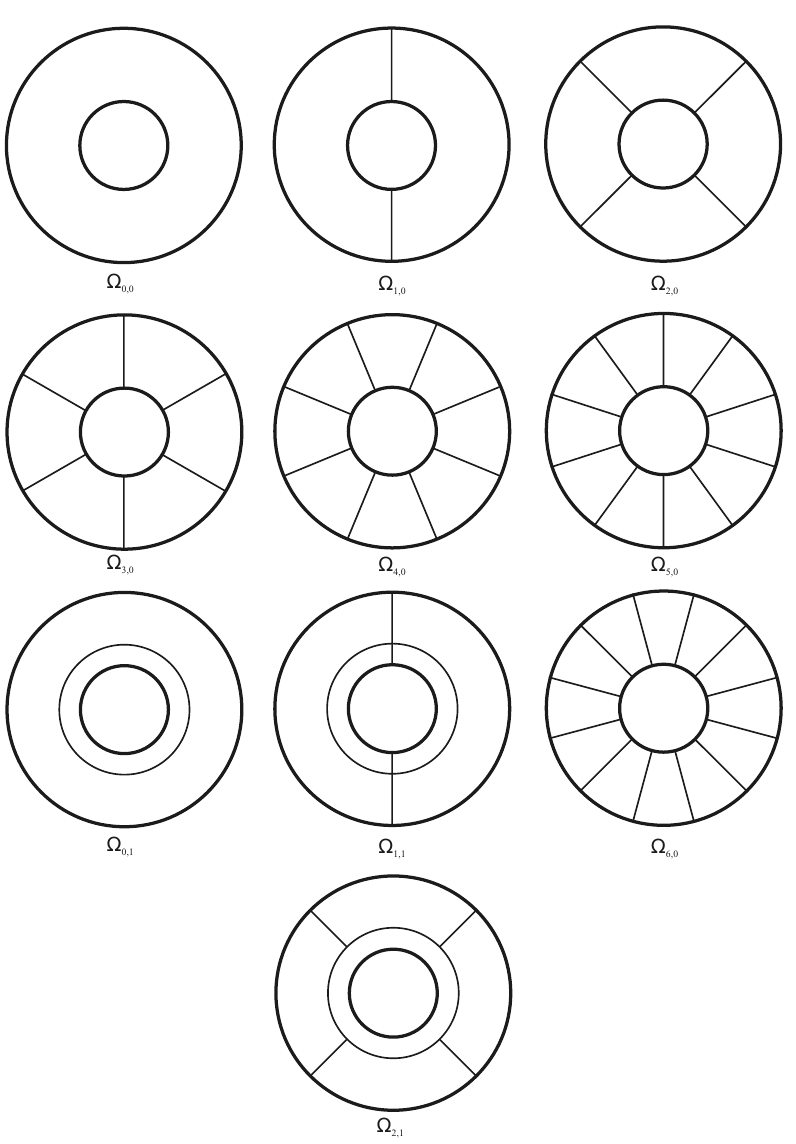
Fig. 4. First ten nodal lines of C - C plates when α = β = 0.4, e r = g r = 5.0, R = 0.5, K f =